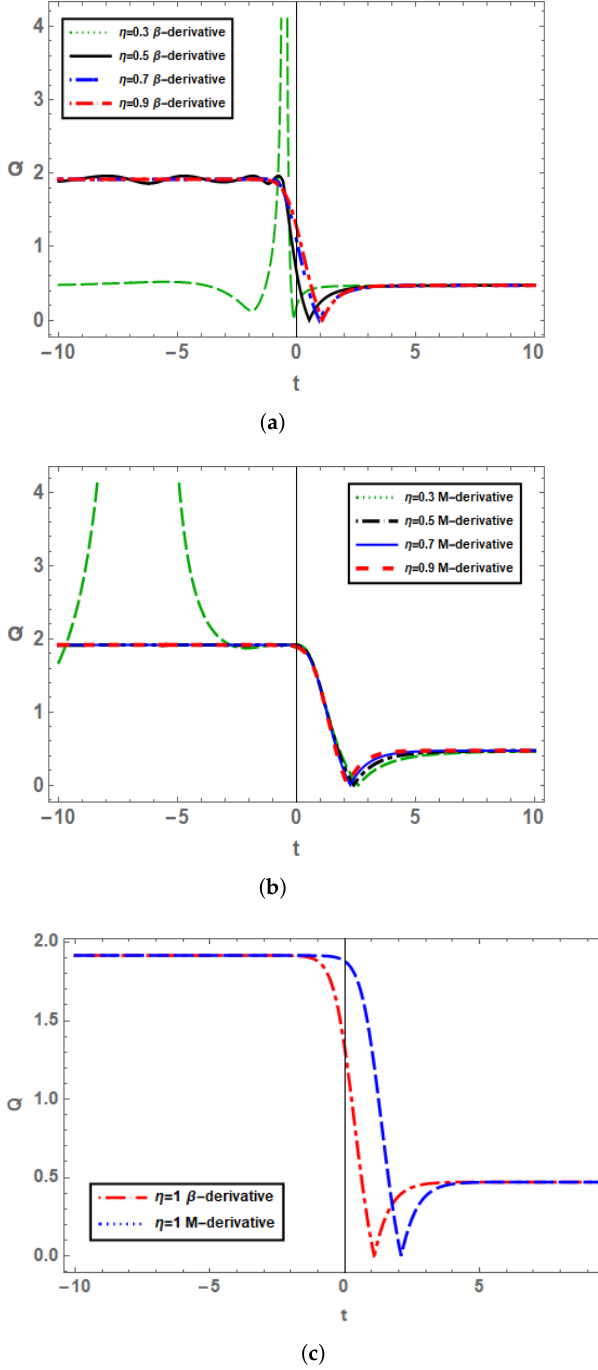
Figure 5. The 2 D plots of Q 4,1 ( x , t ) for both operators taking µ = − 0.5, γ = 0.5, σ = 1.1, and ω = 1 at t = 1 with different values of fractional parameter η